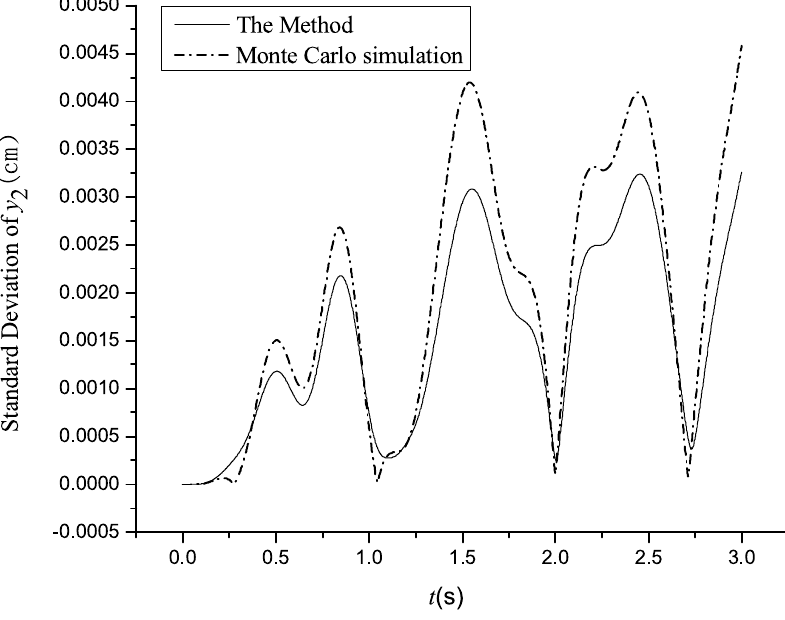
Fig. 5. The standard deviation curve of the displacement y 2 .